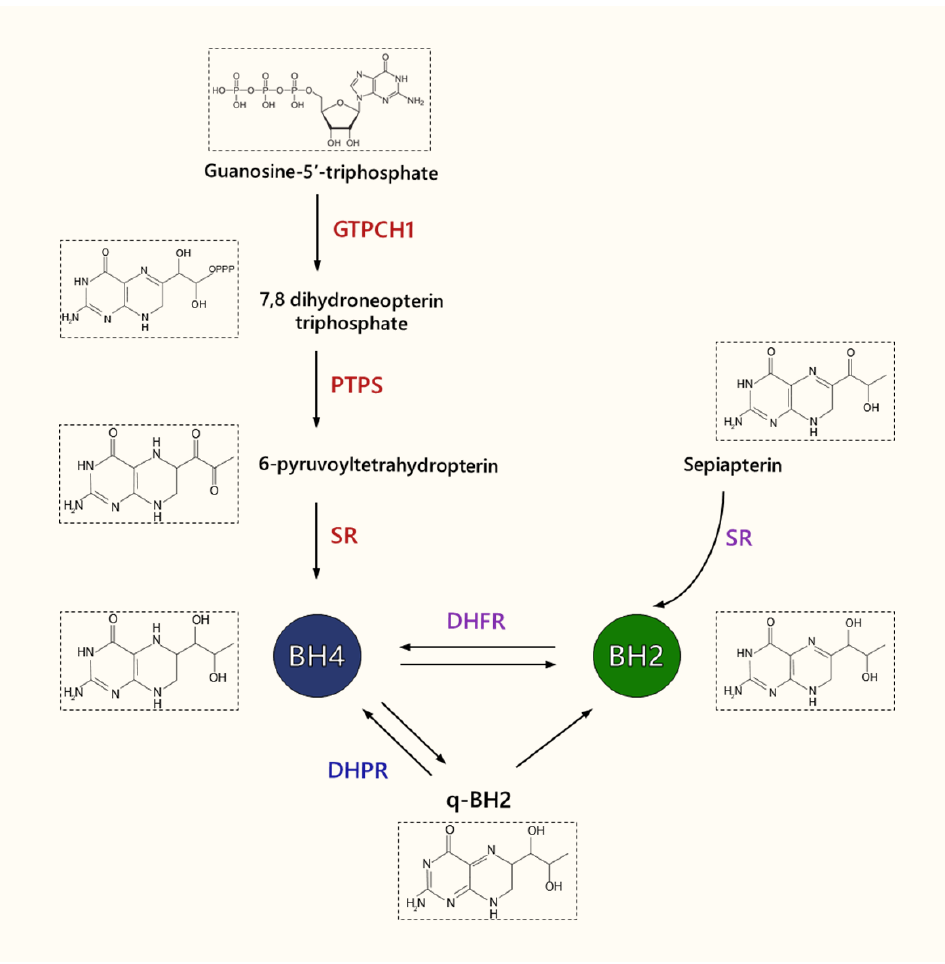
Figure 2. Tetrahydrobiopterin (BH4) biosynthesis pathway. De novo (red): BH4 is produced from guanosine- 5′ -triphosphate (GTP) by enzymes GTP cyclohydrolase 1 (GTPCH1), 6-pyruvoyl-tetrahydrobiopterin synthase (PTPS), and sepiapterin reductase (SR). Salvage (purple): Sepiapterin re- duction into dihydrobiopterin (BH2) by SR, and BH2 conversion into BH4 by dihydrofolate reductase (DHFR). Recycling (blue): quinoid-BH2 reduction into BH4 by dihydropteridine reductase (DHPR).